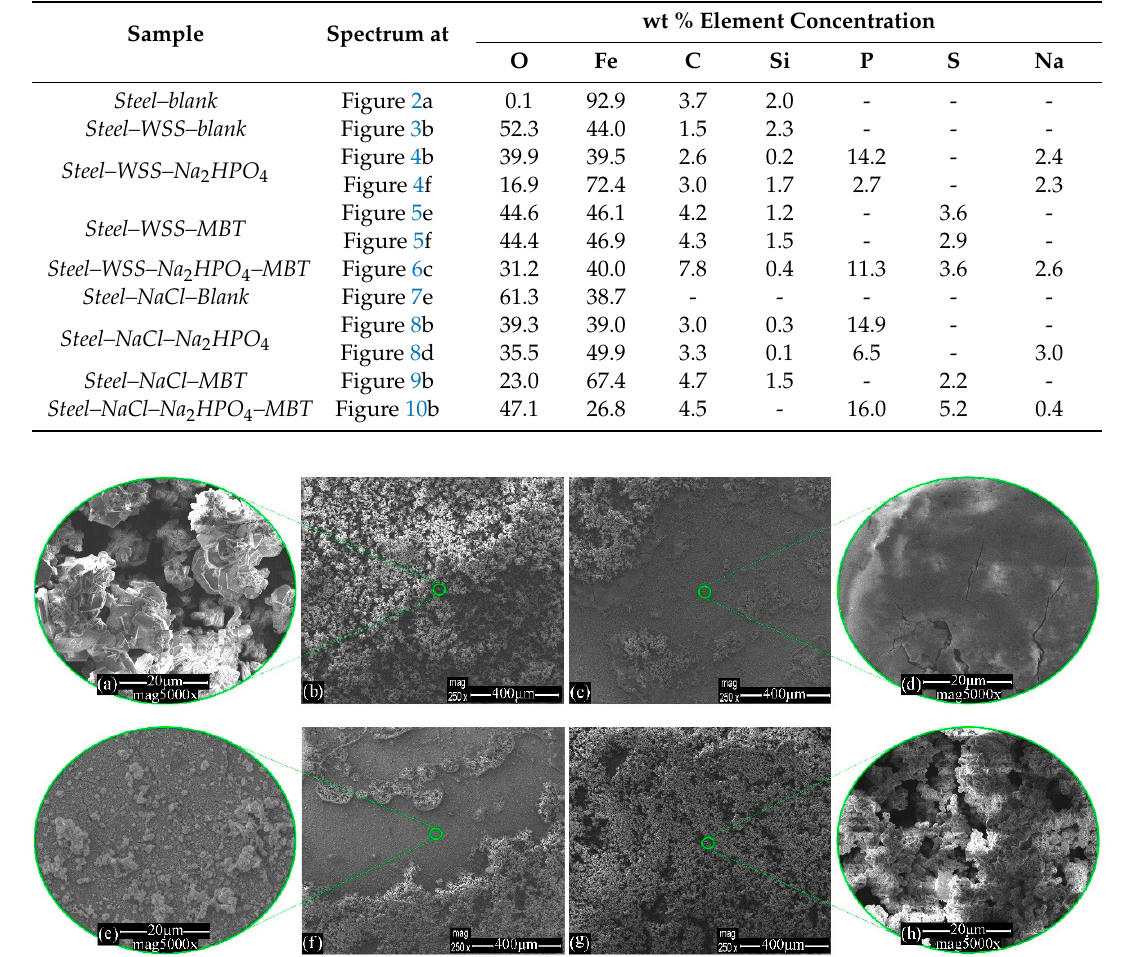
Table 3. Tabulated values of wt % element concentration of mild steel panels prior and after subjection in either WSS, or 3.5 wt % NaCl for 96 h in the presence of inhibitors or not.